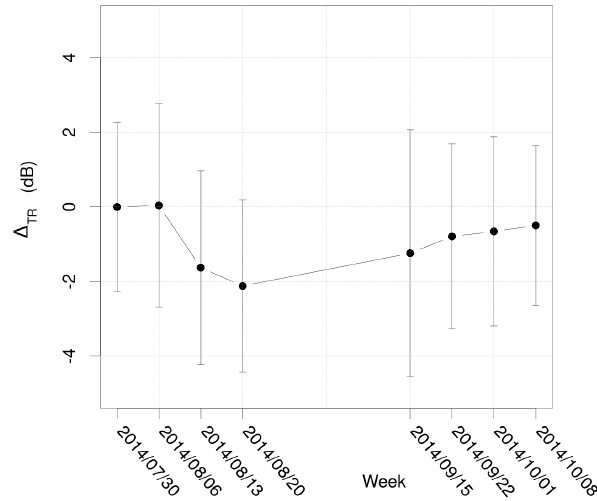
Figure 19. (cid:49) TR , as defined in Sect. 3, computed weekly during the study period for the Bric della Croce radar. The error bars represent its uncertainty.